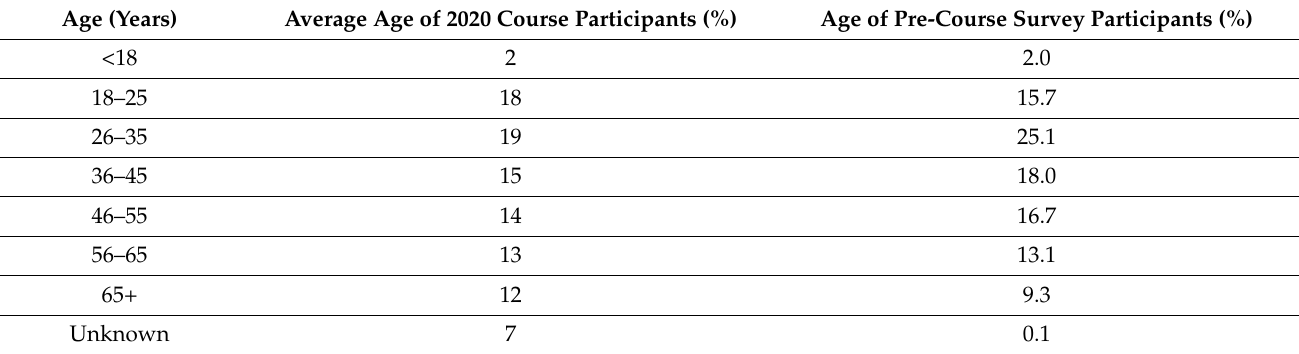
Table A1. Demographics of MOOC participants compared with survey respondents.